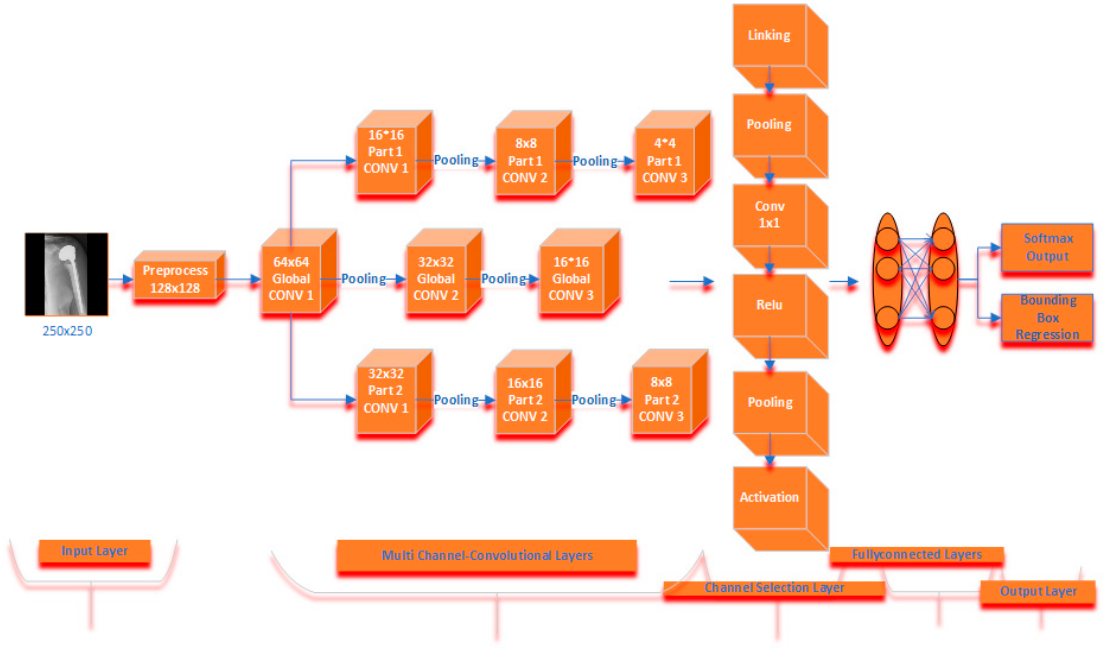
Figure 5. Proposed multichannel model architecture.